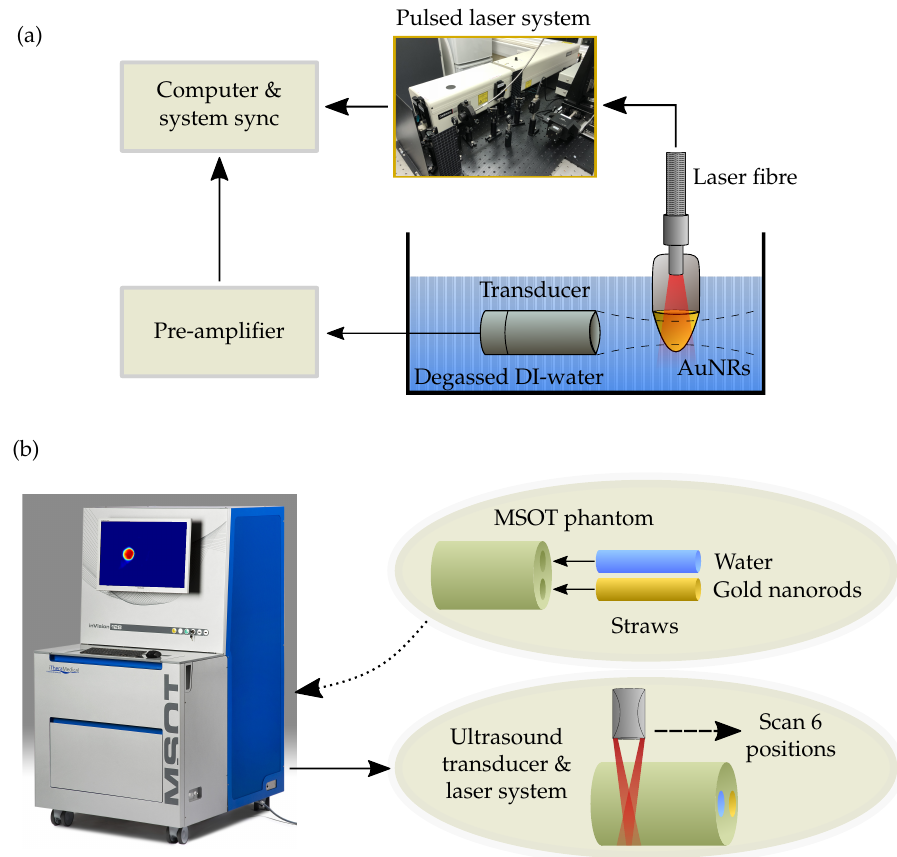
Figure 7. ( a ) Schematic showing the experimental setup for measuring the PA response of the different sized AuNRs at a concentration of 1 × 10 11 NP/mL. ( b ) Experimental schematic showing a straw containing 1 × 10 11 NP/mL of AuNRs and another straw containing a water baseline being placed into a typical turbid, agar phantom before a multispectral scan is performed at 6 positions using the MSOT